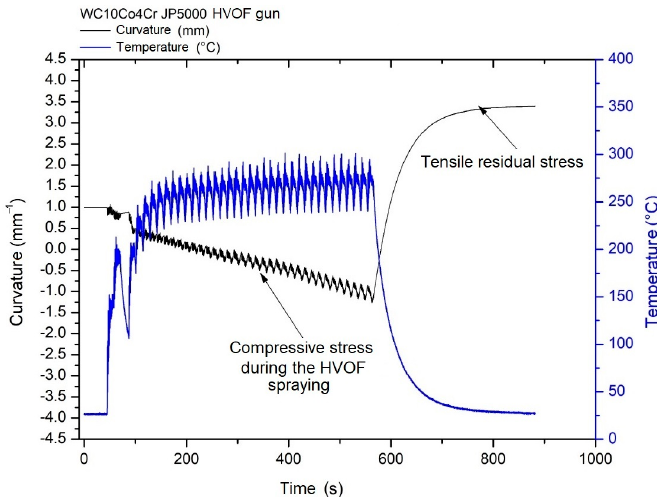
Figure 13. Typical curves obtained with ICP sensor.